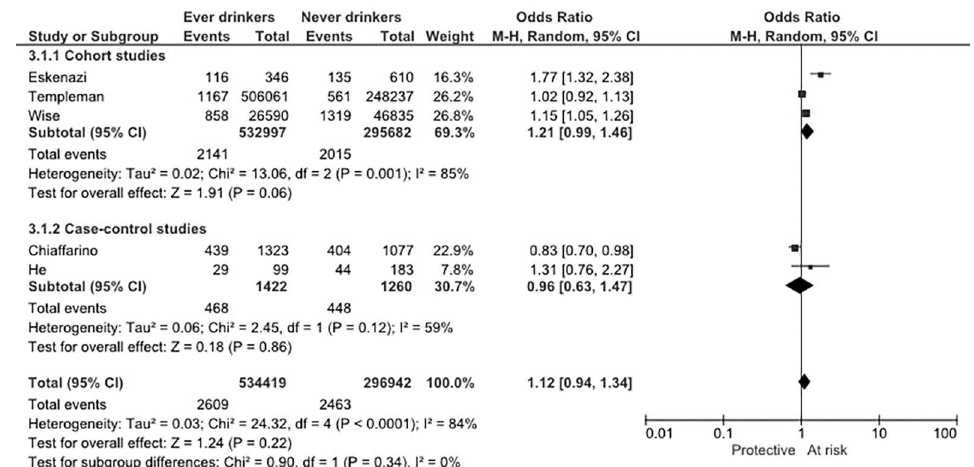
Fig 2. Study specific and summaryodds ratio (OR) of uterine myoma for ever versus no alcohol intake. CI: confidenceinterval.